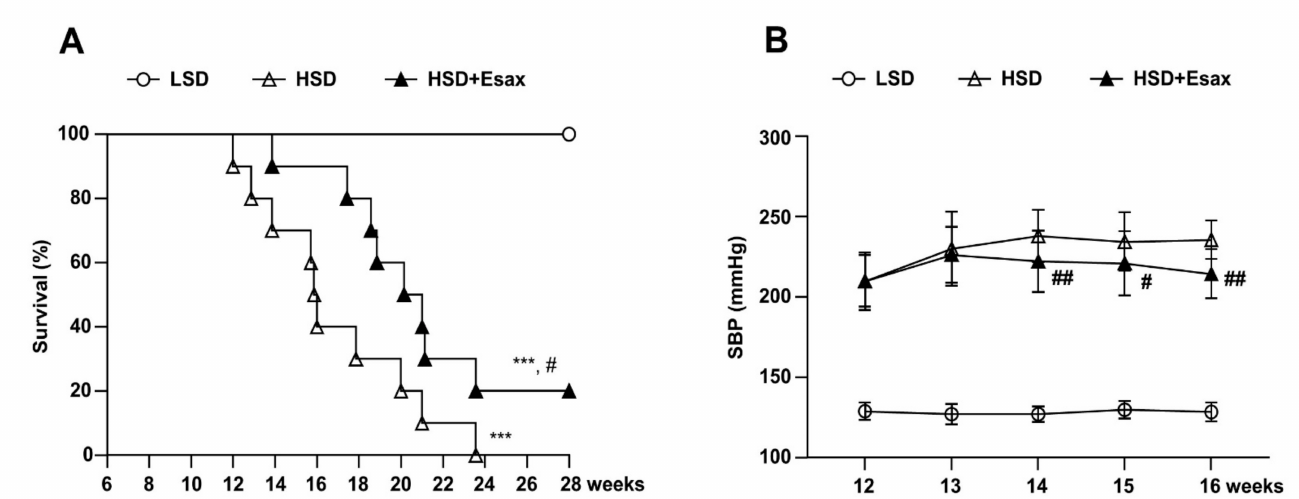
Figure 1. Esaxerenone treatment increases survival and reduces SPB in HSD-fed DSS rats. ( A ) Kaplan–Meier survival analyses in the LSD ( n = 10), HSD ( n = 10), and HSD + Esax ( n = 10) groups of DSS rats. The HSD-fed rats exhibited decreased survival as compared with the LSD-fed rats. The HSD-fed rats receiving esaxerenone showed significantly higher survival than did the HSD-fed rats. ( B ) Time-dependent changes of SBP during feeding LSD, HSD, and HSD + Esax. SBP was gradually increased in the HSD-fed rats; however, esaxerenone treatment significantly reduced SBP. *** p < 0.001 vs. LSD; # p < 0.05, ## p < 0.01 vs.